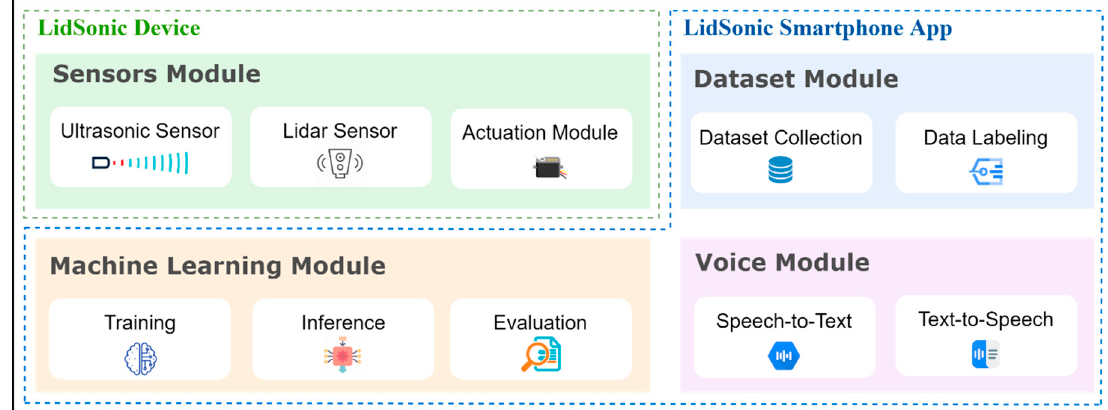
Figure 7. LidSonic: the software design.